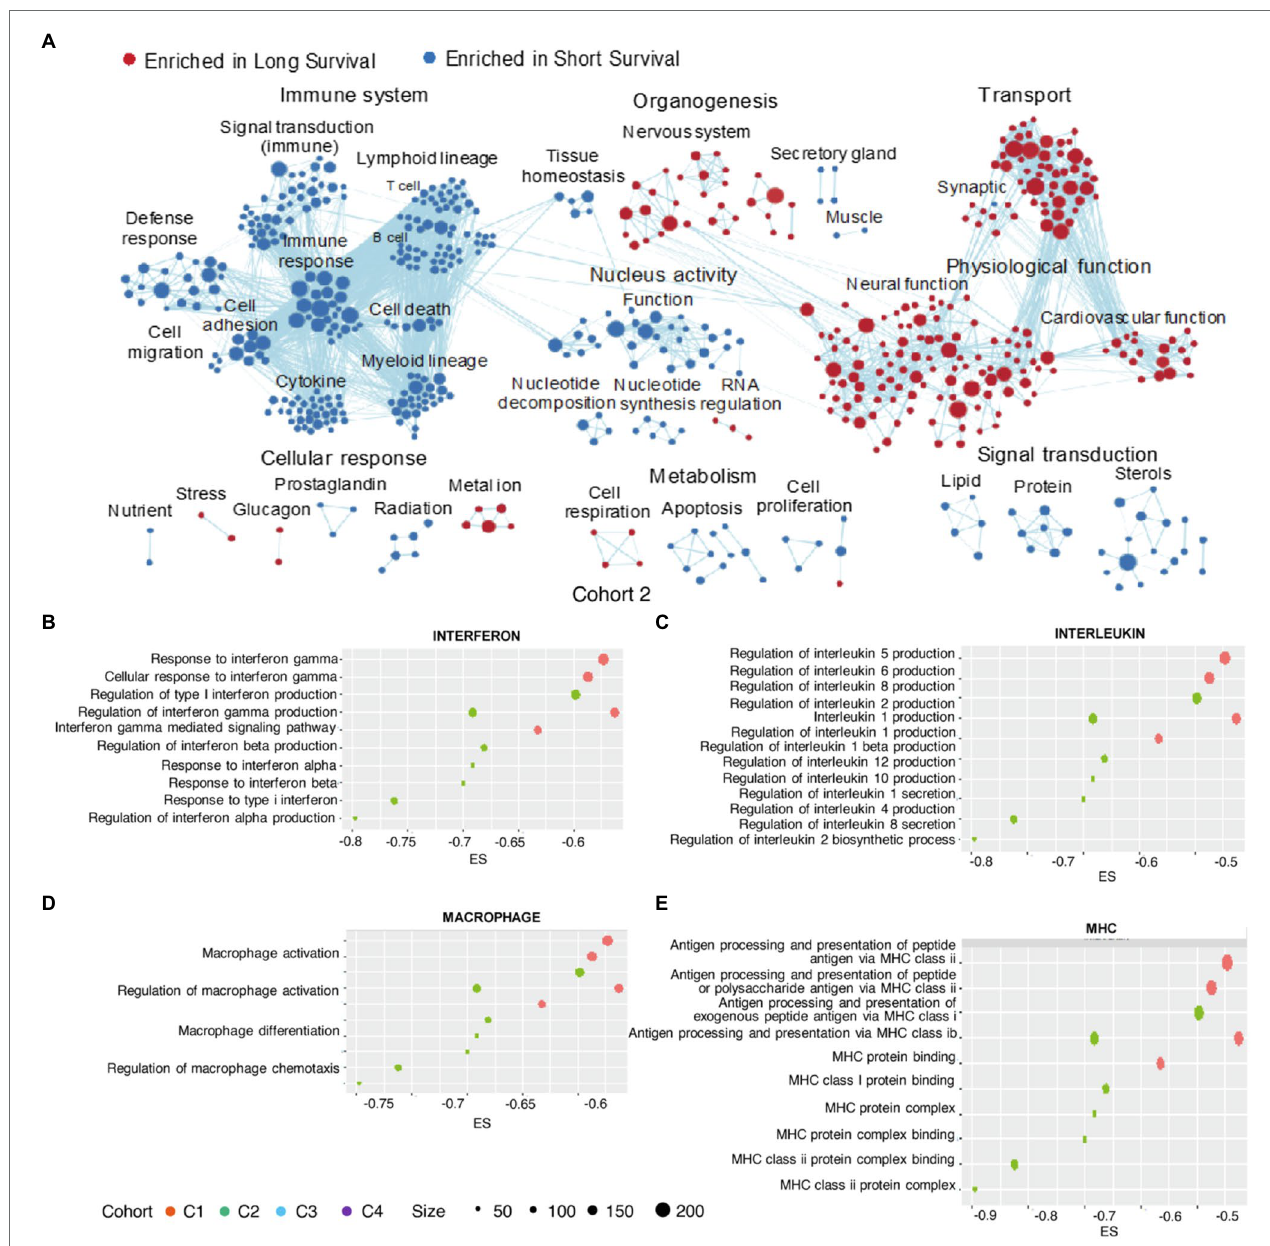
FIGURE 3 | GO enrichment in clusters. Enrichment map of GO terms (selected according to p < 0.05) aggregated by functions for Cohort 2 (A) . Enrichments scores for GO terms (selected according to p < 0.05) associated with the immune-related (B) interferons, (C) interleukins, (D) macrophages, and (E) major histocompatibility complex (MHCs). GO, Gene Ontology; MHC, major histocompatibility